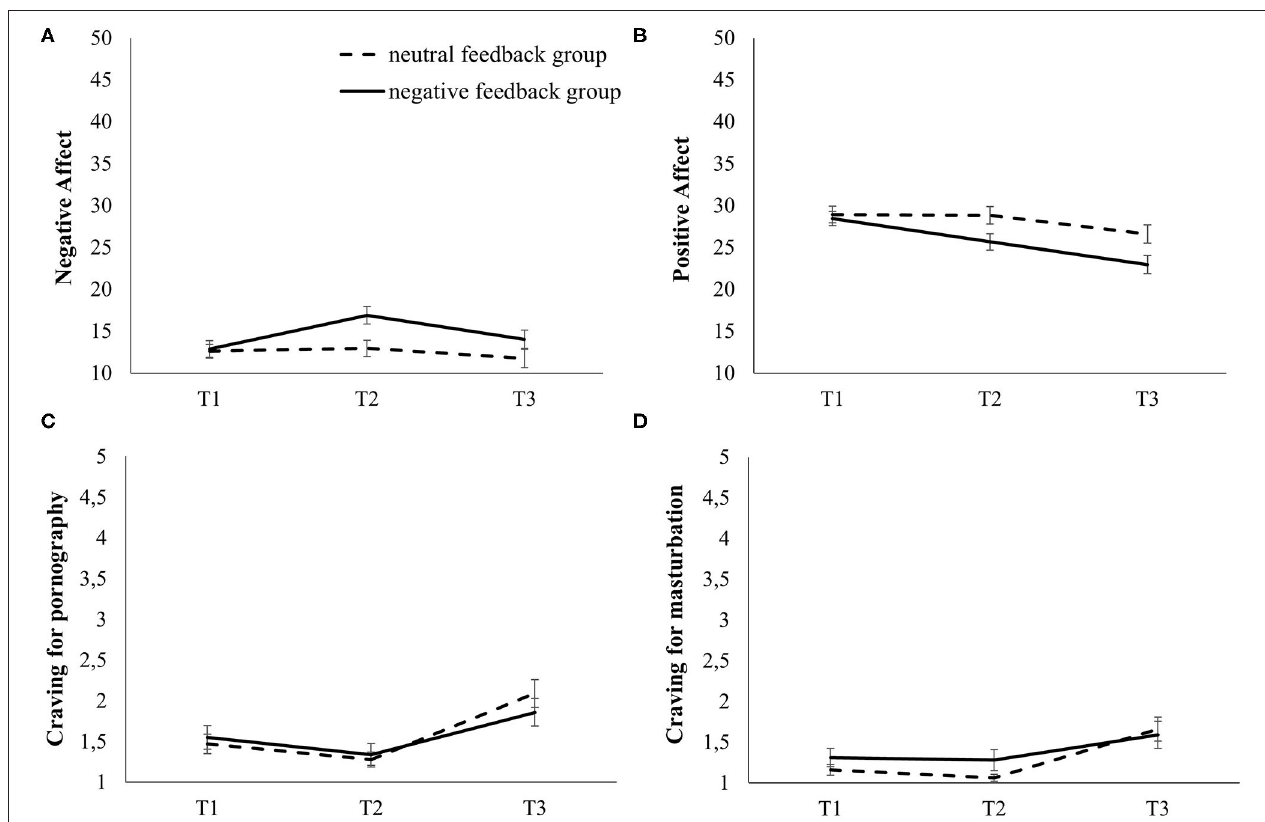
FIGURE 2 | Time courses for affect and craving in both groups over the three measurement time points of the experiment. (A) Negative affect, (B) positive affect, (C) craving for pornography, (D) craving for masturbation. T1: baseline; T2: after the affect manipulation; T3: after the sexual cue reactivity